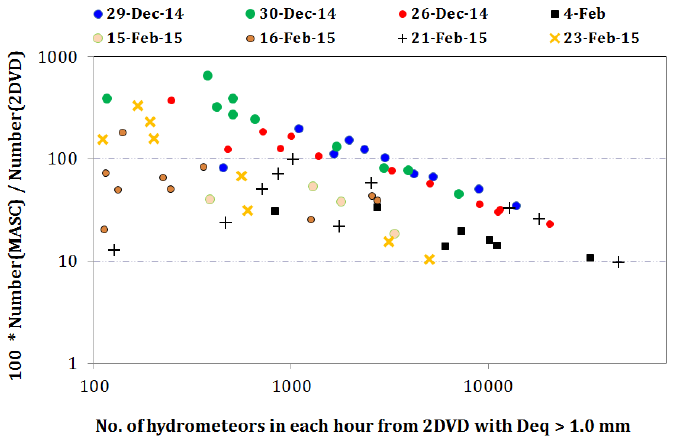
Figure 10. Particle collection comparison between the MASC and the 2DVD (in Figure 9) for selected